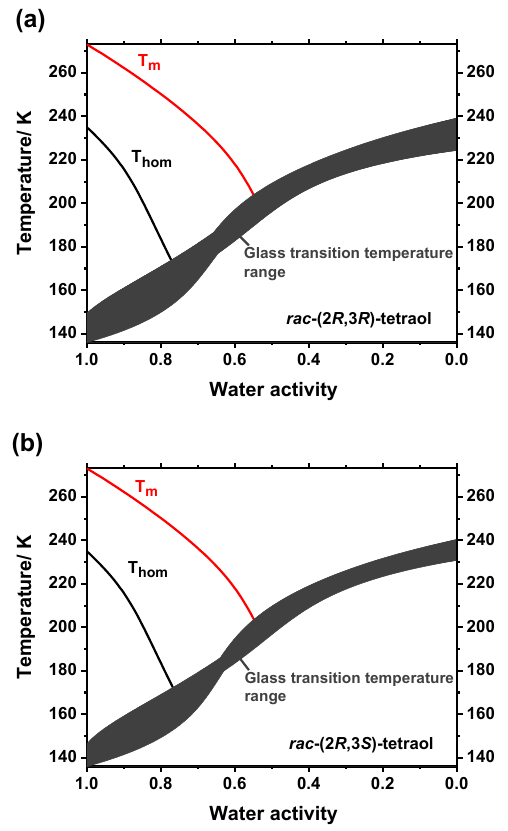
Figure 4. Partial phase diagrams of mixtures of rac -(2 R ,3 R) -tetraol with water (a) and rac -(2 R ,3 S) -tetraol with water (b) plotted as a function of water activity. In addition to the ice-melting-point line ( T m ; red line) the homogeneous ice nucleation temperatures ( T hom ; black line) are shown. The dark grey area indicates the glass transi- tion temperatures and their uncertainty; see text for